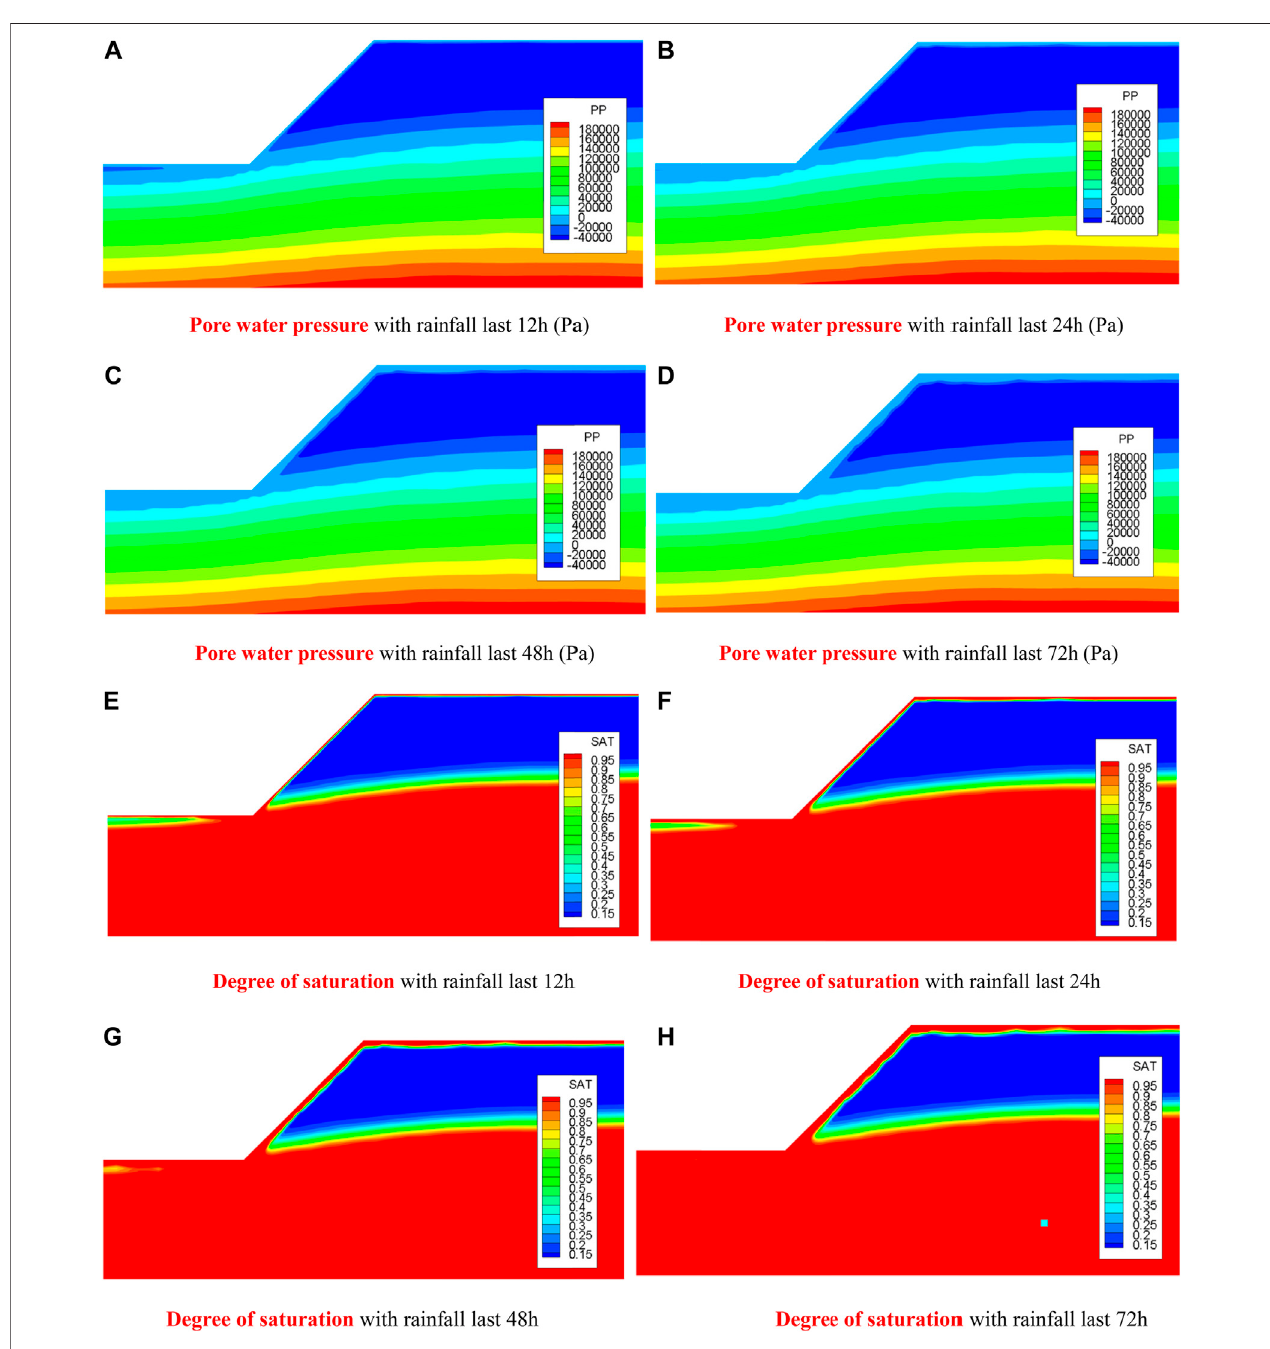
FIGURE 7 | Pore water pressure and saturation under different rainfall duration: (A) Pore water pressure with rainfall last 12h (Pa), (B) Pore water pressure with rainfalllast 24 h (Pa), (C) Pore water pressure with rainfalllast 48 h (Pa), (D) Pore water pressure with rainfall last 72 h (Pa), (E) Degree of saturation with rainfall last 12 h, (F) Degree of saturation with rainfall last 24 h, (G) Degree of saturation with rainfall last 48 h, (H) Degree of saturation with rainfall last 72 h.